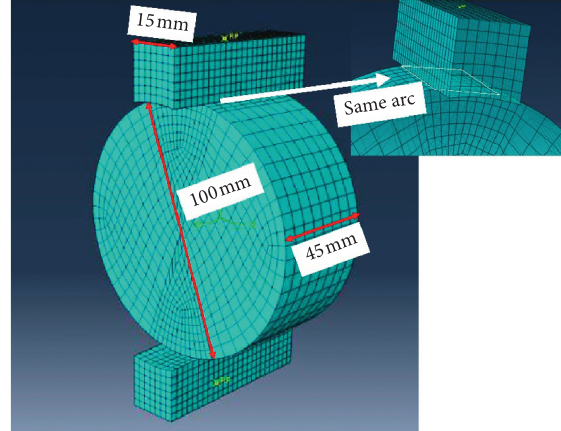
Figure 5: Schematic diagram of the geometrical